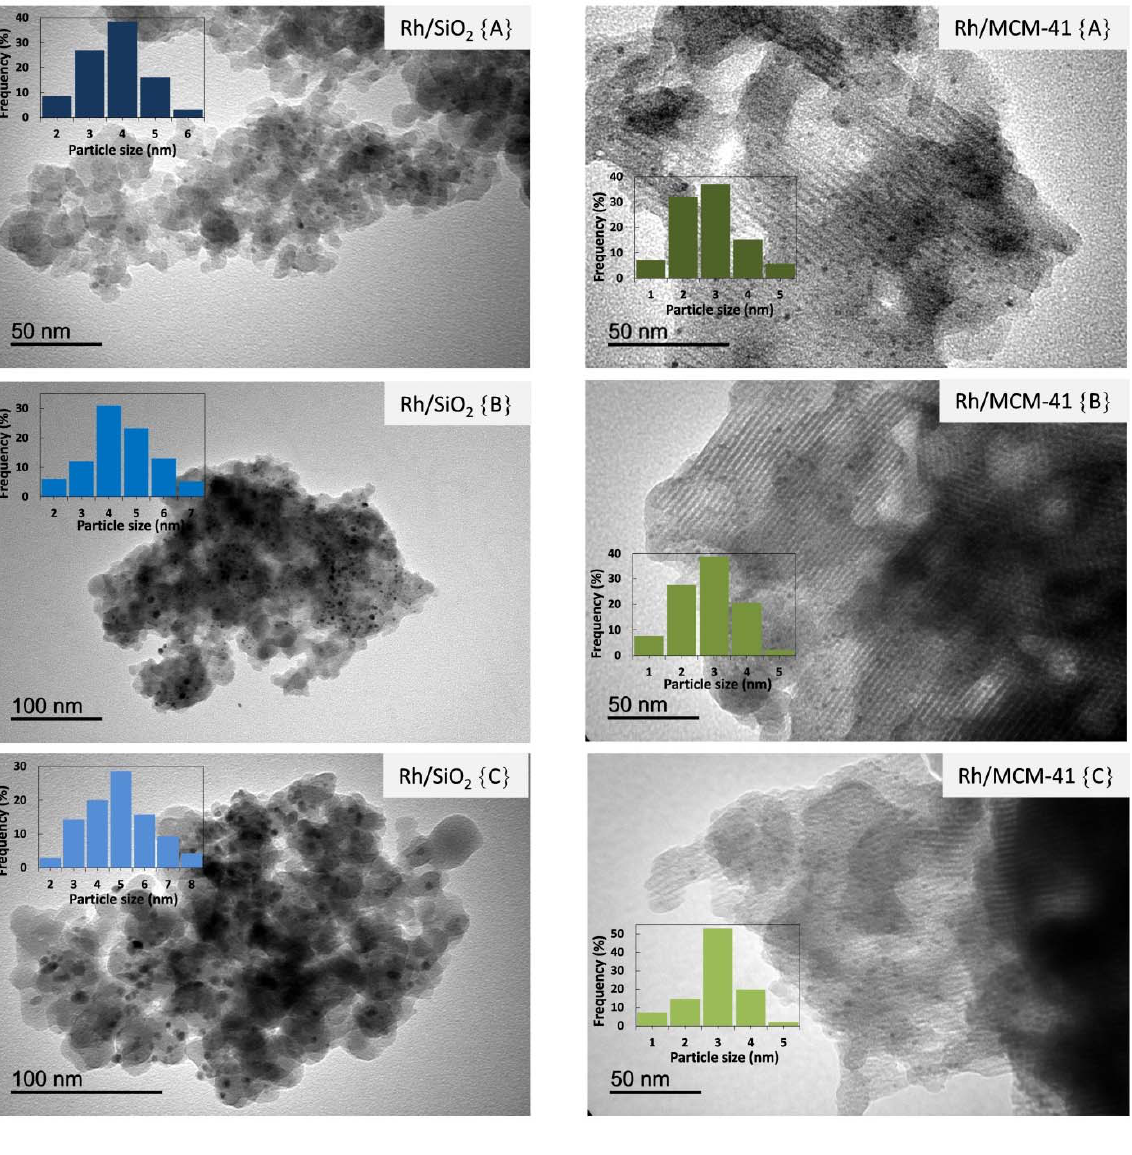
Figure 7. TEM images of Rh/SiO 2 and Rh/MCM-41 catalysts; reduced ( A ); after catalytic testing ( B ); and after catalytic testing with addition of water ( C ). Catalytic testing at same conditions as indicated in Table